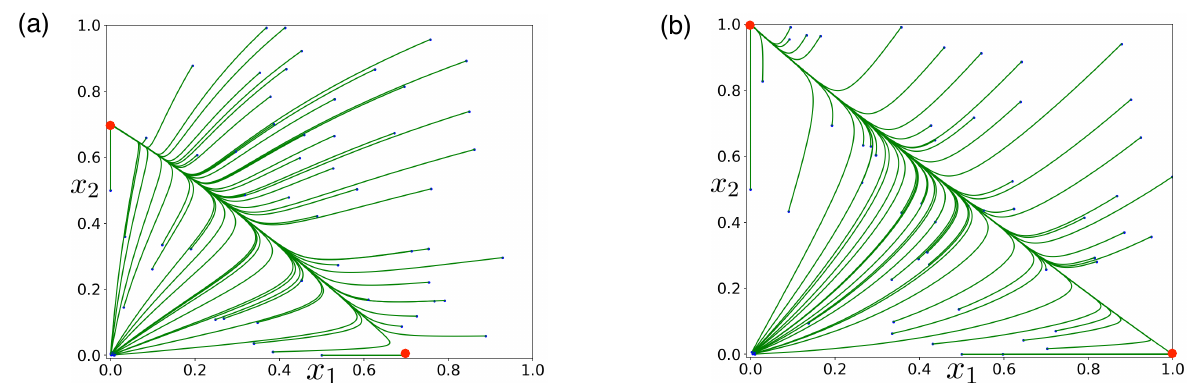
Bifurcation diagram representing x ⇤ Figure 12. heat map (b) for a more intuitive understanding. Parameters used: # = 0.13, h k = 1.4, g = 0.5.